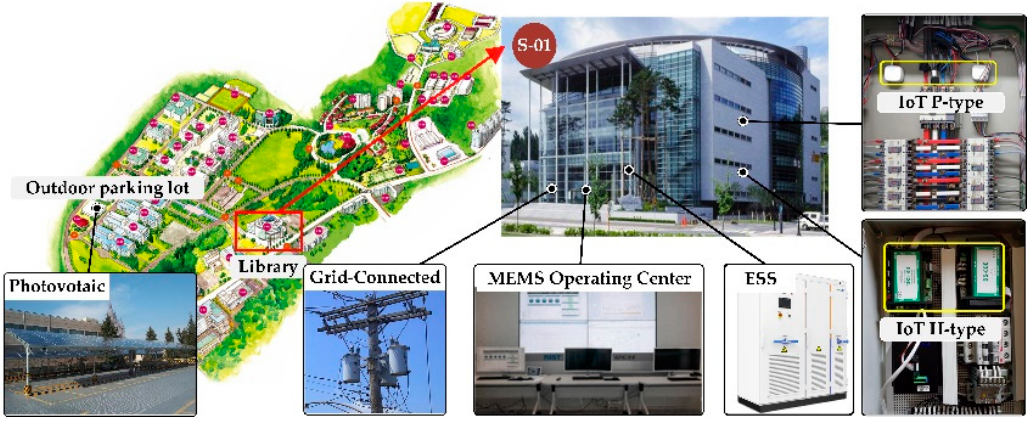
Figure 1. Architecture of the implemented IoT-based campus MG.